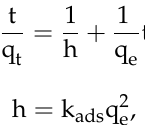
Figure 8. Nonlinear models of Langmuir adsorption isotherm at dosages ( a ) 0.1 g/L, ( b ) 0.5 g/L, ( c ) 1.0 g/L and Freundlich adsorption isotherm at ( d ) 0.1 g/L, ( e ) 0.5 g/L, ( f ) 1.0 g/L.